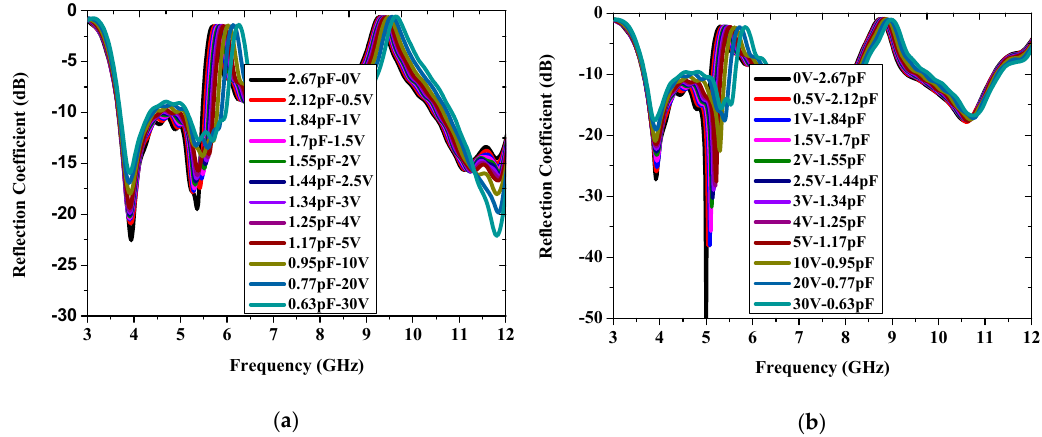
Figure 10. Reflection coefficient of the proposed tunable DRA: ( a ) simulation and ( b ) measurement. The far-field radiation characteristics under four continuously changing reverse bias voltages